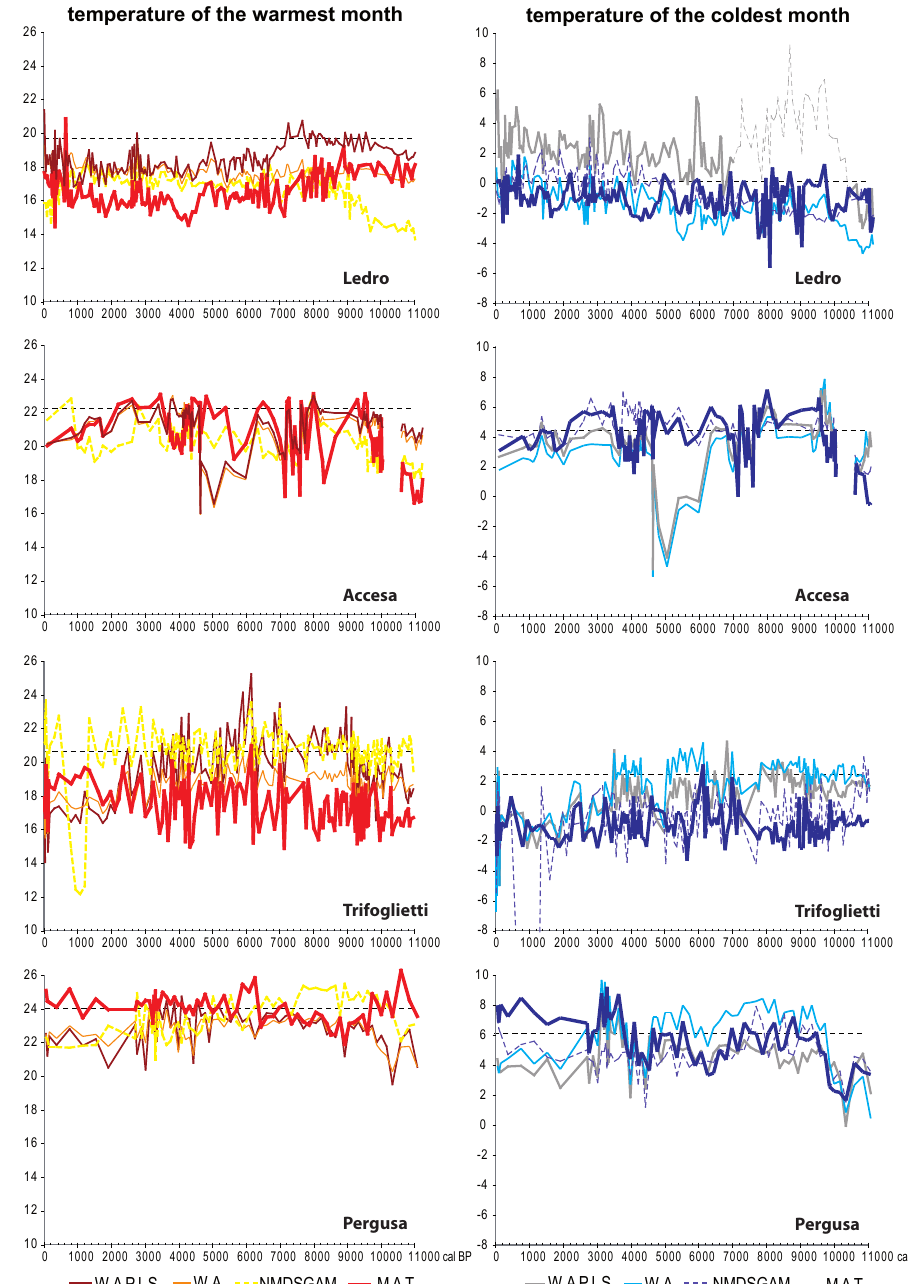
Fig. 3. Pollen-based temperatures (warmest and coldest month). Climate values are estimated using four methods: the modern analogue technique (MAT), the non-metric multidimensional scaling/generalized additive model method (NMDS/GAM), weighted averaging (WA), and weighted-average partial least-squares regression (WAPLS). Modern values are indicated with a horizontal dotted line. The thin dotted grey curve (temperature of the coldest month, Ledro) corresponds to unrealistic